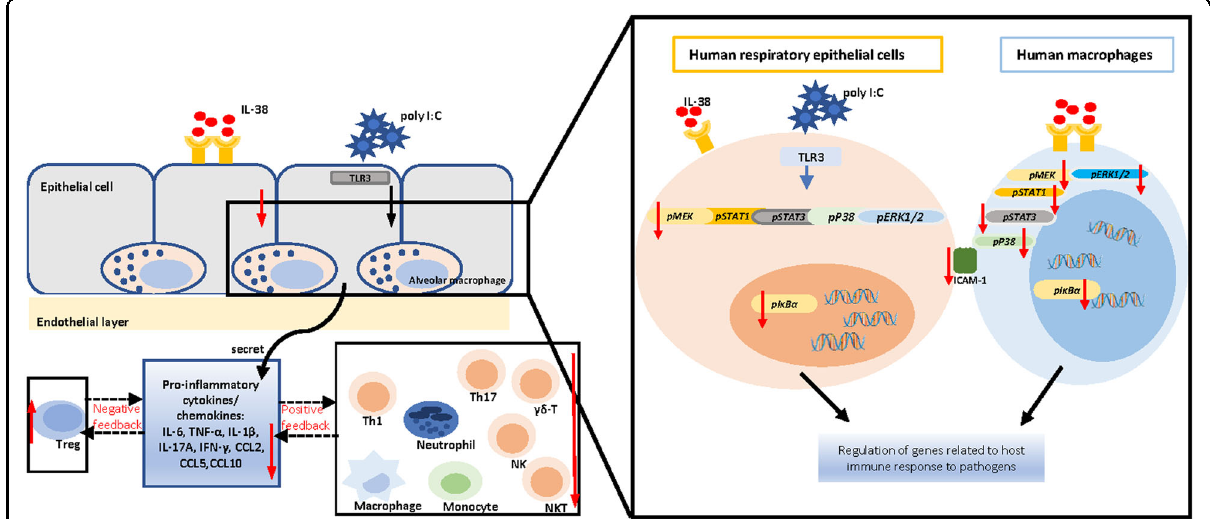
Fig. 7 The role and molecular mechanism of IL-38 in respiratory viral infection. IL-38 was able to alleviate in fl ammatory responses in vitro by inhibiting poly(I:C)-induced over production of pro-in fl ammatory cytokines and chemokines through intracellular STAT1, STAT3, p38 MAPK, ERK1/2, MEK and NF- κ B signaling pathways. IL-38 targeted genes were associated with host innate immune response to virus in vitro. In animal study, IL-38 could mitigate poly(I:C)-induced lung injury by suppressing in fl ammatory responses by upregulating Treg cells but downregulating Th1, Th17, NK, NKT and γδ T